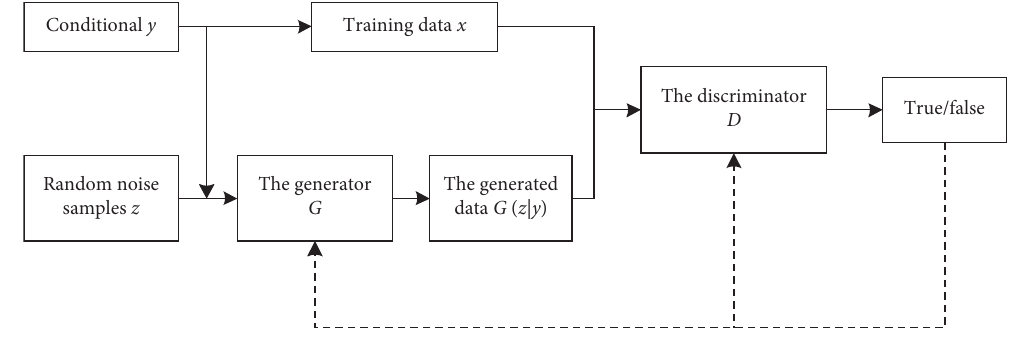
Figure 2: The basic framework of CGAN. CGAN has an additional condition y.